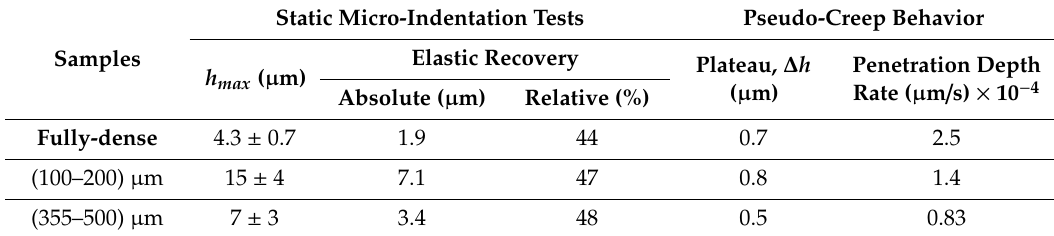
Table 3. Characteristic parameters of loading–unloading curves and pseudo-creep behavior evaluated by micro-indentation tests.